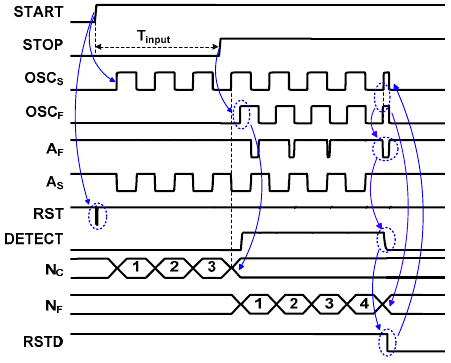
Figure 4. Timing waveform of the alignment detector.